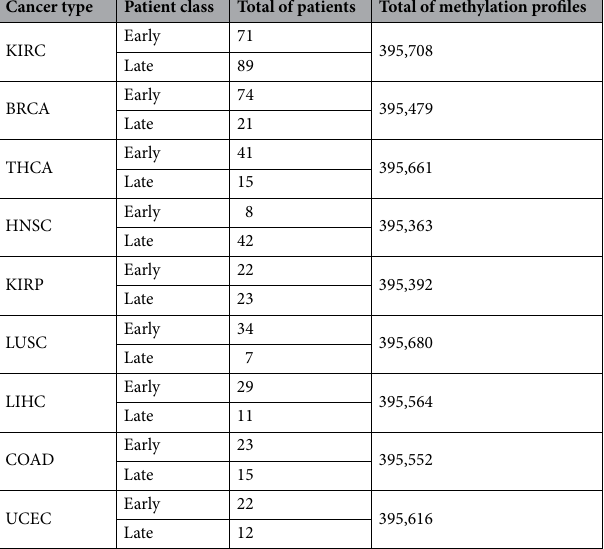
Table 3. The description of TCGA datasets used in this study. KIRC kidney renal clear cell carcinoma, BRCA breast invasive carcinoma, THCA thyroid carcinoma, HNSC head and neck squamous cell carcinoma,